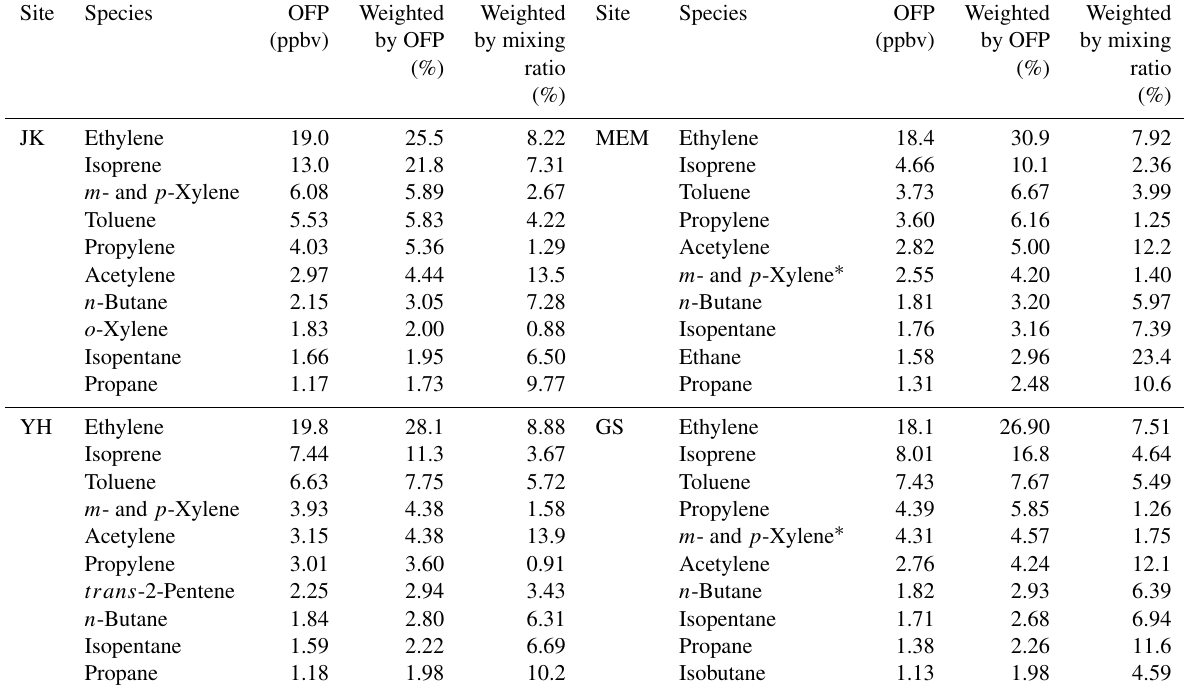
Table 5. Top 10 VOCs ranked according to calculated ozone formation potential (OFP) and their corresponding percentage weighted by mixing ratio.